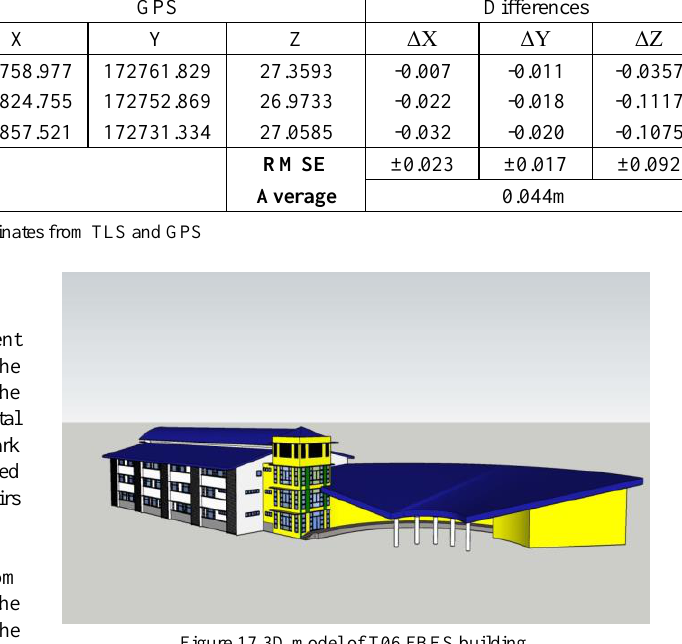
Figure 17 3D model of T06 FBES